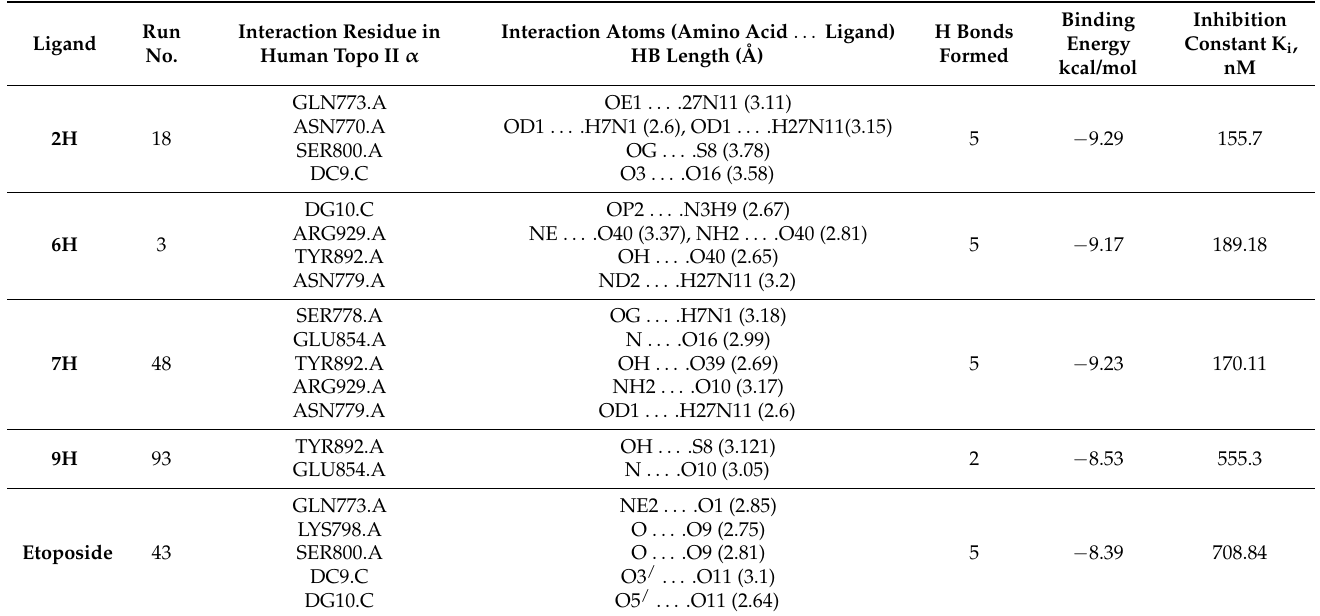
Table 4. Computed molecular interactions of the four derivatives of TUDHIPP ( 2H , 6H , 7H , and 9H ) with human DNA topoisomerase II α